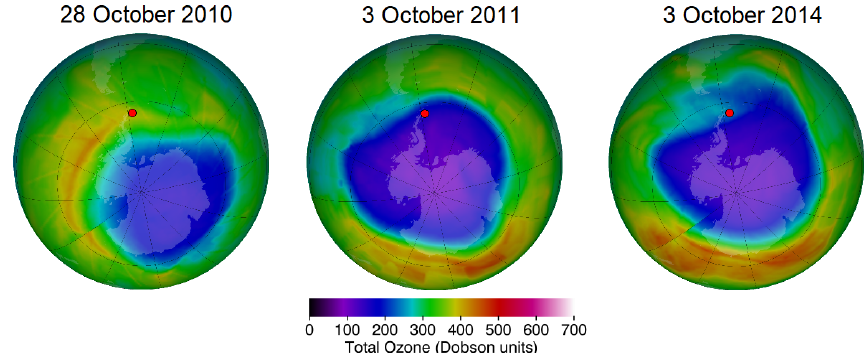
Figure 1. The approximate position of Marambio Base (red dot) relative to the southern polar vortex (outside, inside, and on the edge) on different October days. Image adapted from Ozone Hole Watch